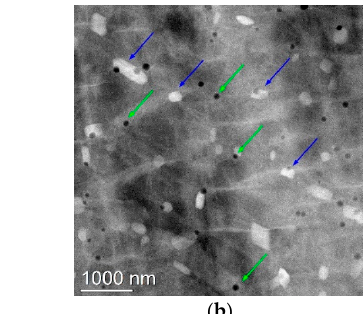
Figure 2. Scanning Electron Microscopy (SEM) images of the ( a ) Co-SLS and ( b ) Co-PIM samples.